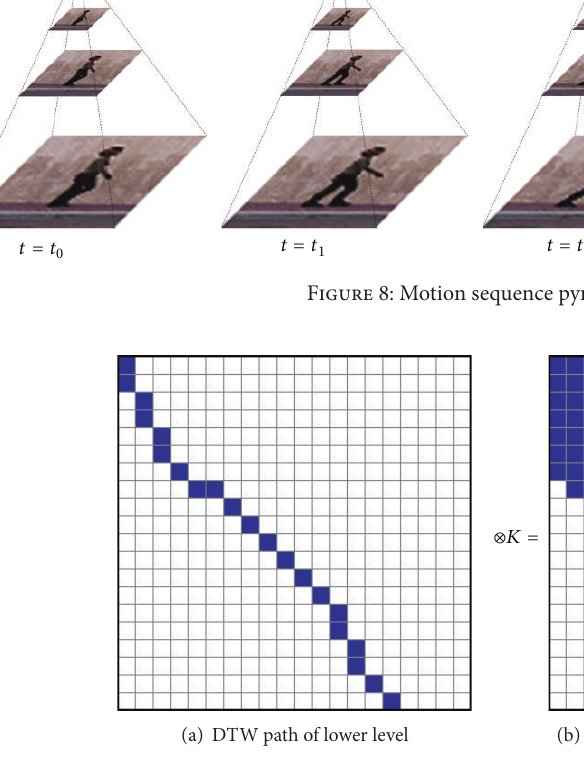
Figure 9: Coarse-to-fine DTW.